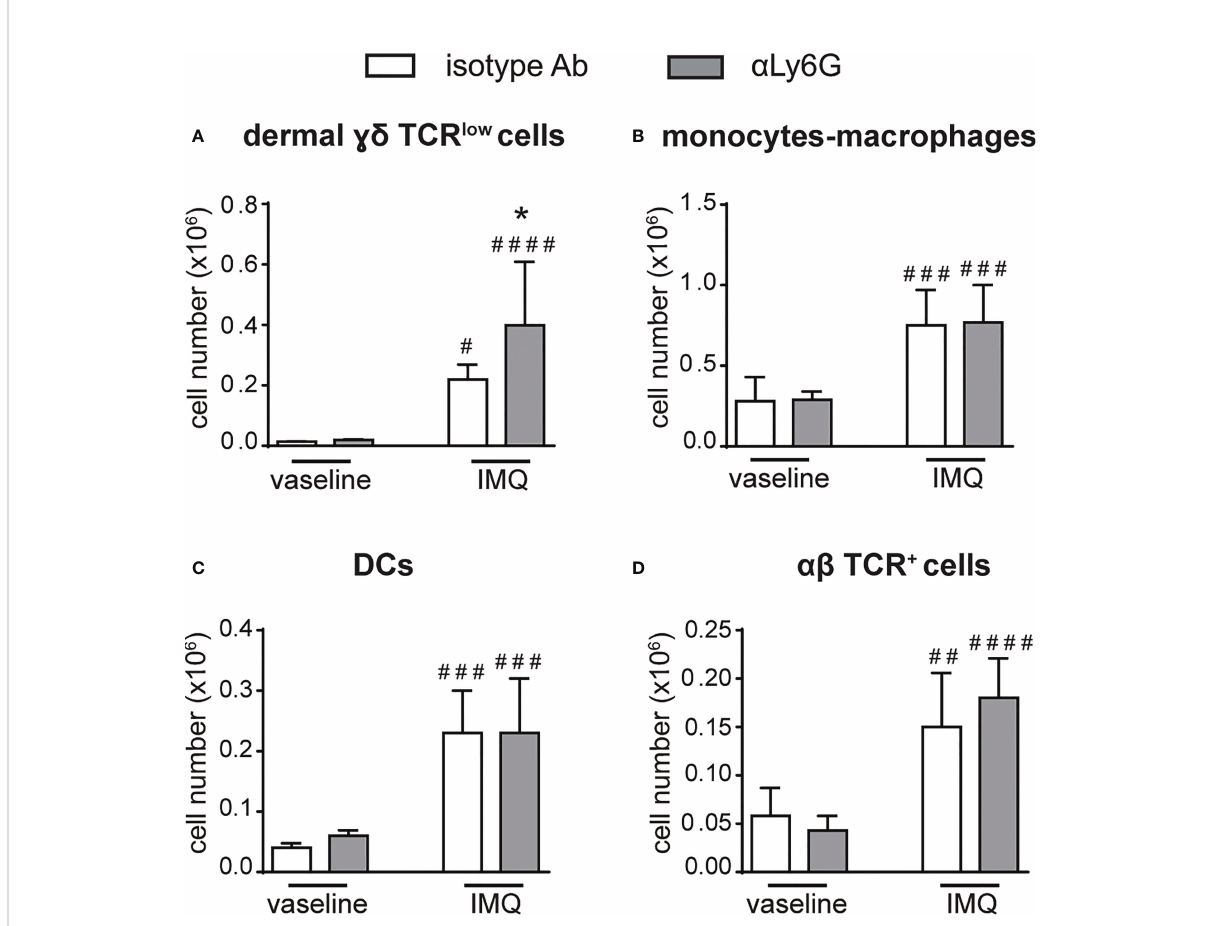
FIGURE 4 The in fi ltration of gd T cells is increased in the skin of neutrophil-depleted mice treated with IMQ. The dorsal skin of mice was topically treated with IMQ-containing cream (Aldara ® ) or vaseline for 6 consecutive days. Mice were injected with the depleting antibody a Ly6G or isotype control Ab. Total skin (2x2 cm) was digested and analyzed by fl ow cytometry. Panels report the total number of: dermal gd TCR low T cells (A) ; monocytes/M f (CD11b high Ly6G - CD11c low/- MHCII low/- cells plus CD11b high Ly6G - CD11c low / - MHCII high cells) (B) ; DCs (CD11c +/high MHCII high ) (C) ; ab TCR + T cells (D) . Data are pooled from 2 separate experiments and are expressed as means ± SD (n = 8-10 mice). Statistical differences of IMQ- treated vs . vaseline-treated mice (#) and IMQ-treated control vs . neutrophil-depleted mice (*) are reported. #/* P ≤ 0.05; ## P ≤ 0.01; ### P ≤ 0.001; #### P ≤ 0.0001 by 1-way ANOVA with Bonferroni ’ s